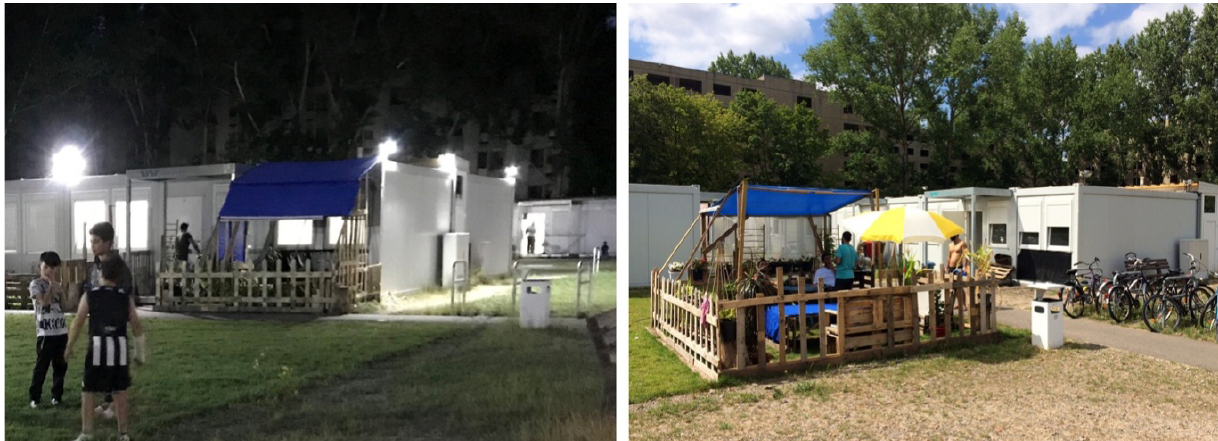
Figure 7. The controlling of appropriated spaces at the Tempohome in Wollenberger Straße. Source: Darweesh and Misselwitz, taken in